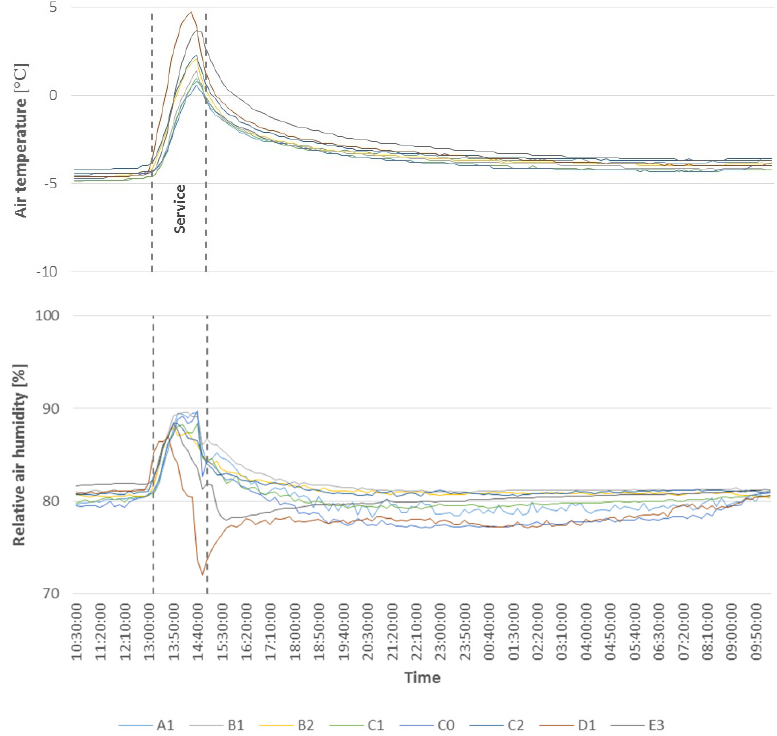
Figure 8. The course of air temperature and relative humidity inside the building during the winter period (24 January 2019).